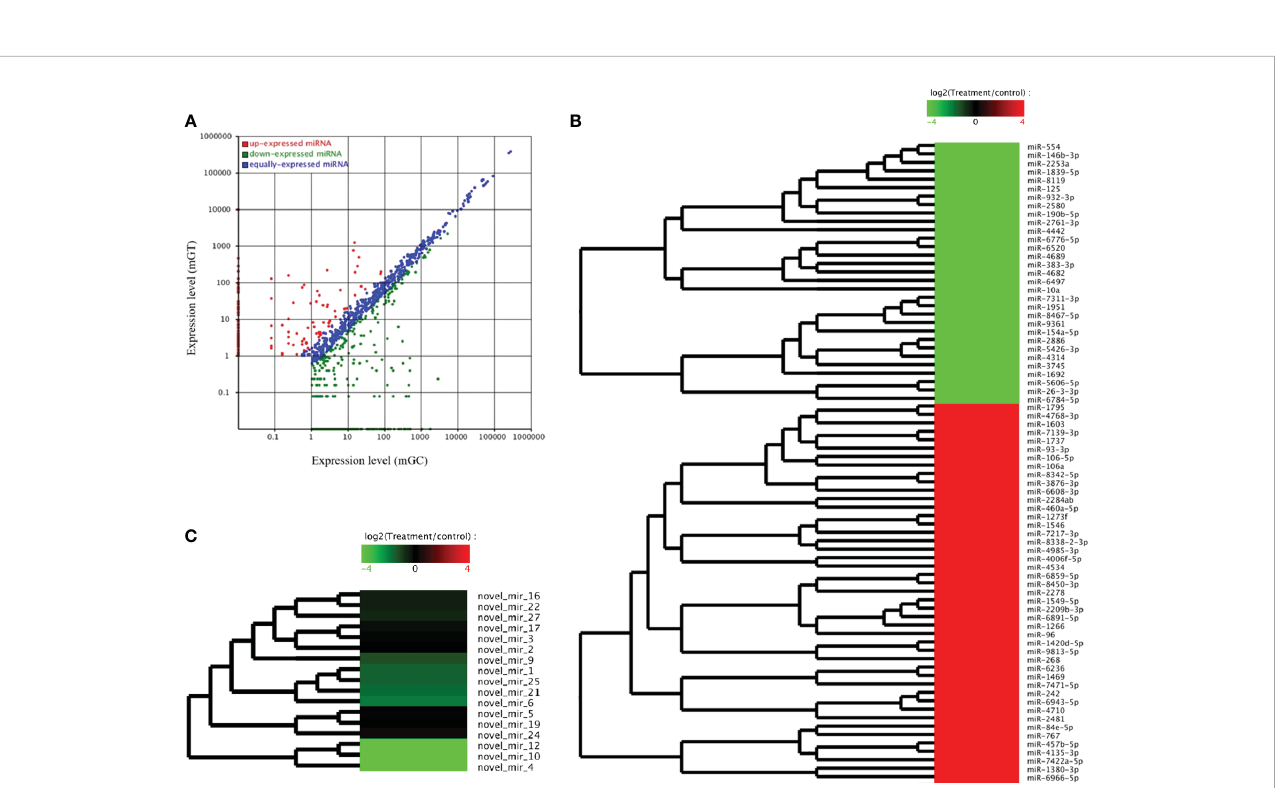
FIGURE 4 Analysis of the differentially expressed miRNAs (DEMs) in the gills of Carassius auratus infected with Aeromonas hydrophila . (A) Scatter plots of the DEMs. Each point represents one miRNA, and the abscissa and ordinate values indicate the expression levels of the miRNAs in the control and infected fi sh, respectively. (B, C) Cluster analysis of the partially known miRNAs (B) and the novel miRNAs (C) with similar expression